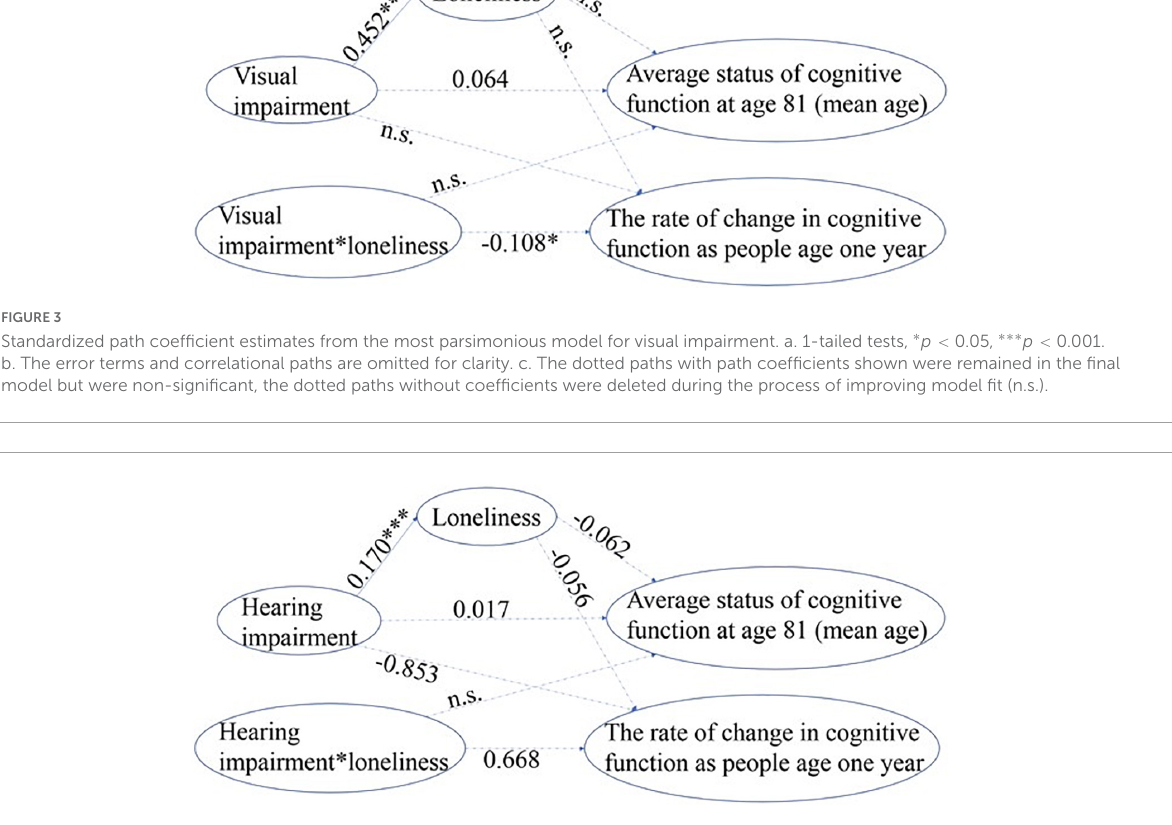
FIGURE4 Standardized path coefficient estimates from the most parsimonious model for hearing impairment. a. 1-tailed tests, ∗ p < 0.05, ∗∗∗ p < 0.001. b. The error terms and correlational paths are omitted for clarity. c. The dotted paths with path coefficients shown were remained in the final model but were non-significant, the dotted paths without coefficients were deleted during the process of improving model fit